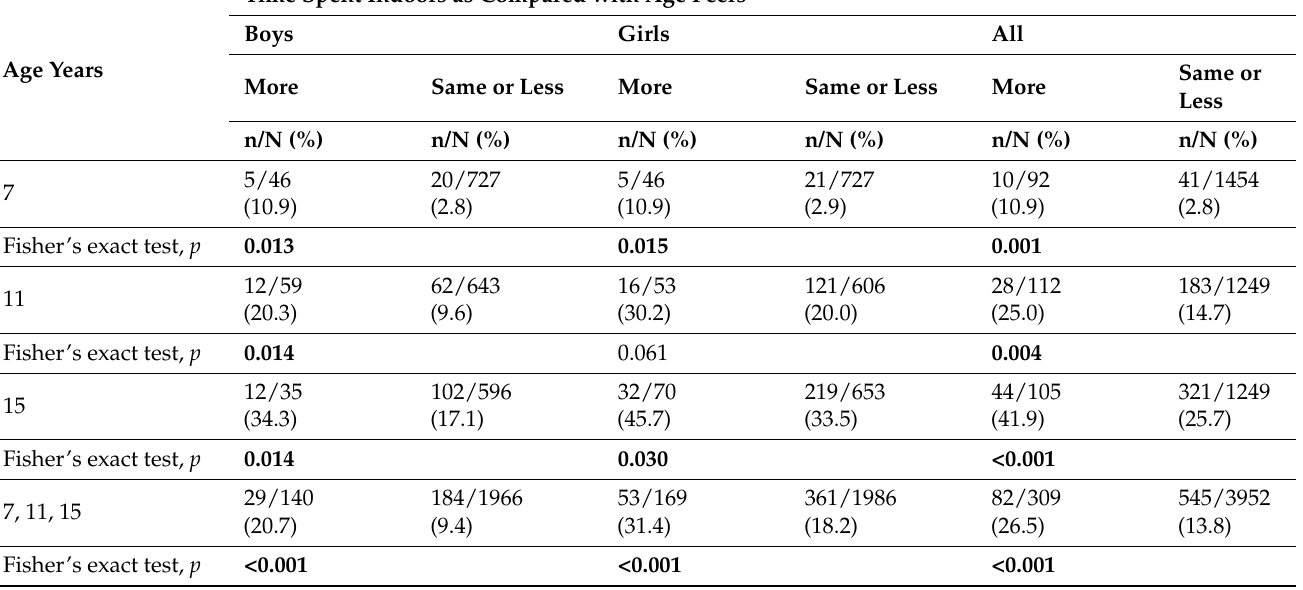
Table 4. Prevalence of myopia according to parents’ estimates of whether their child spends more time indoors than age peers.